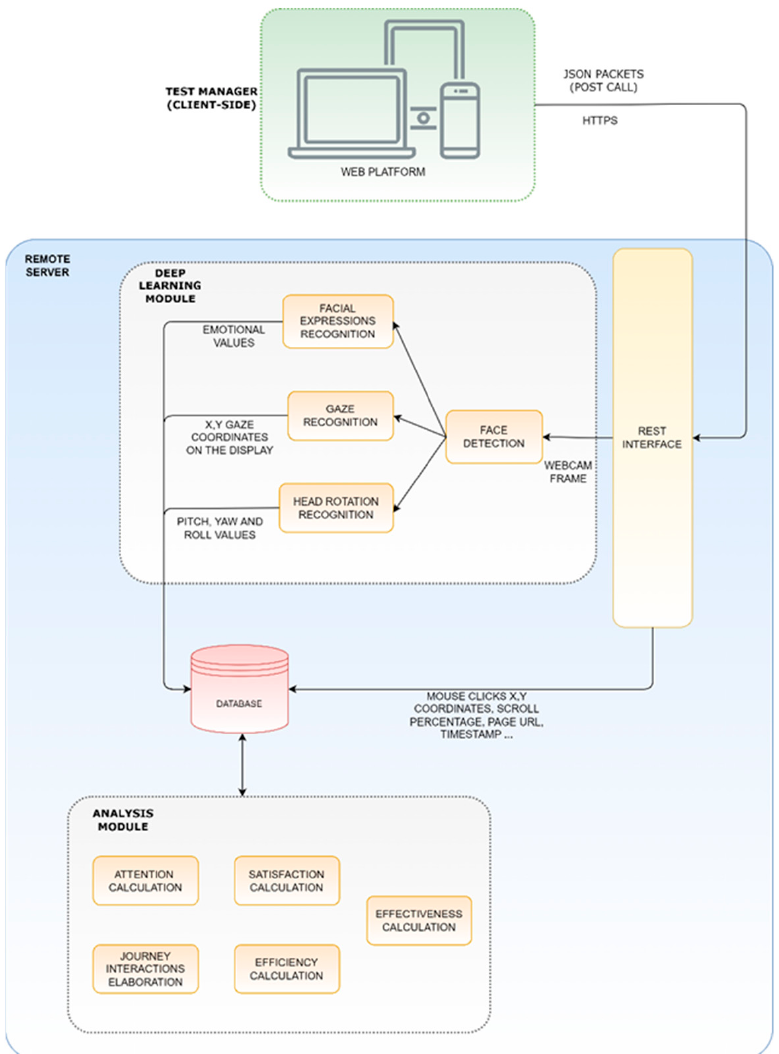
Figure 1. The proposed framework architecture.